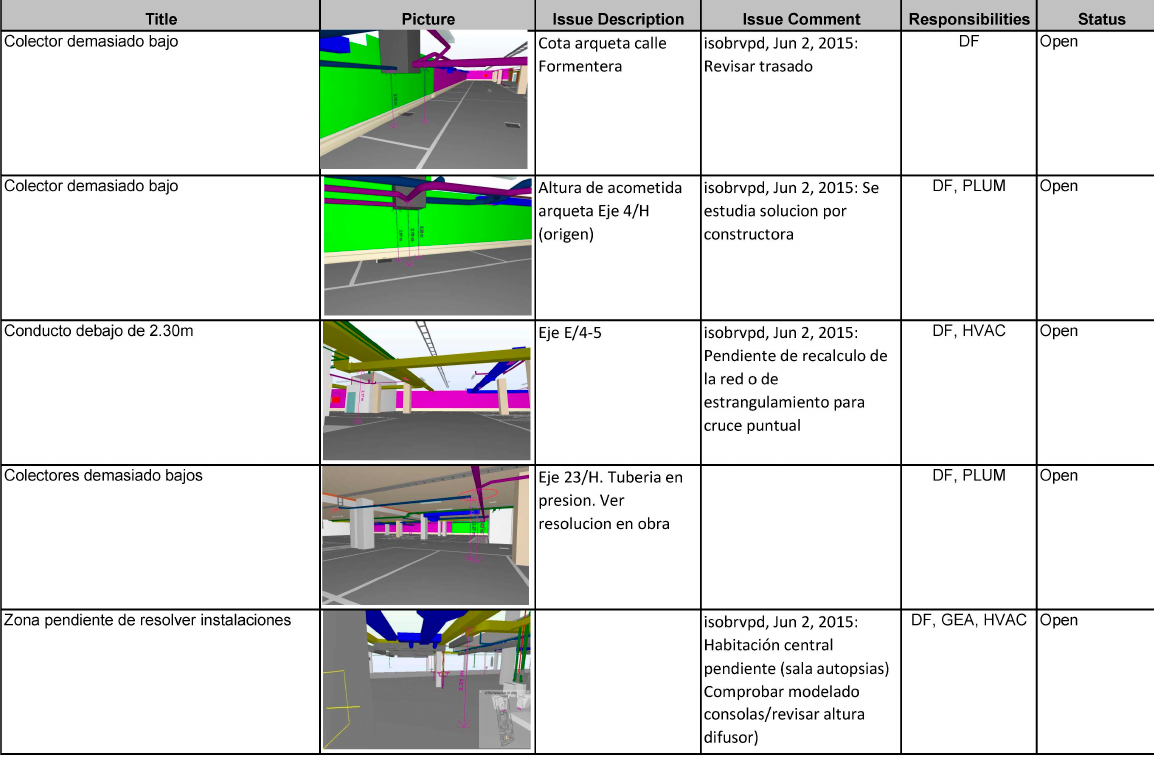
Figure 9. Information elaborated by BIM Manager to communicate incidents to all agents. Solibri Model Checker module of communication.